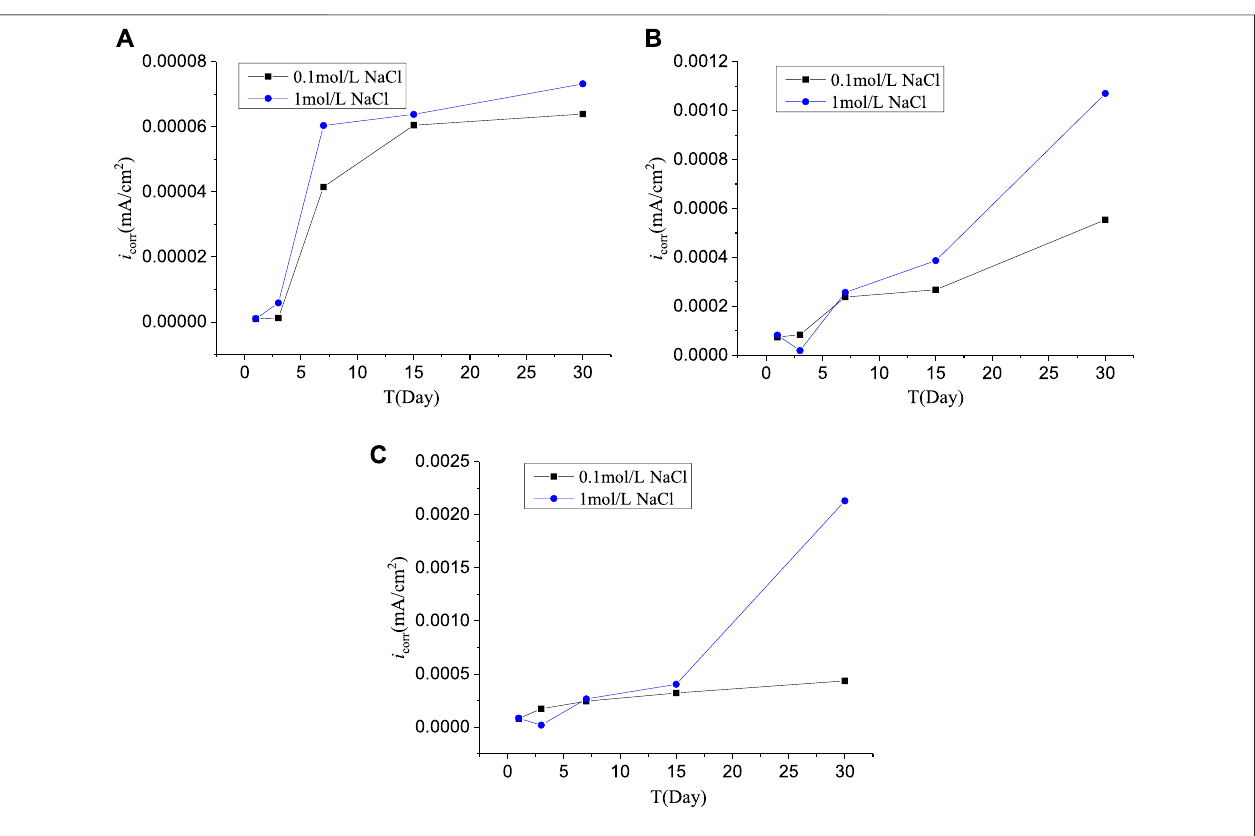
FIGURE 10 | Corrosion current density (A) S1 and S4; (B) S2 and S5; (C) S3 and